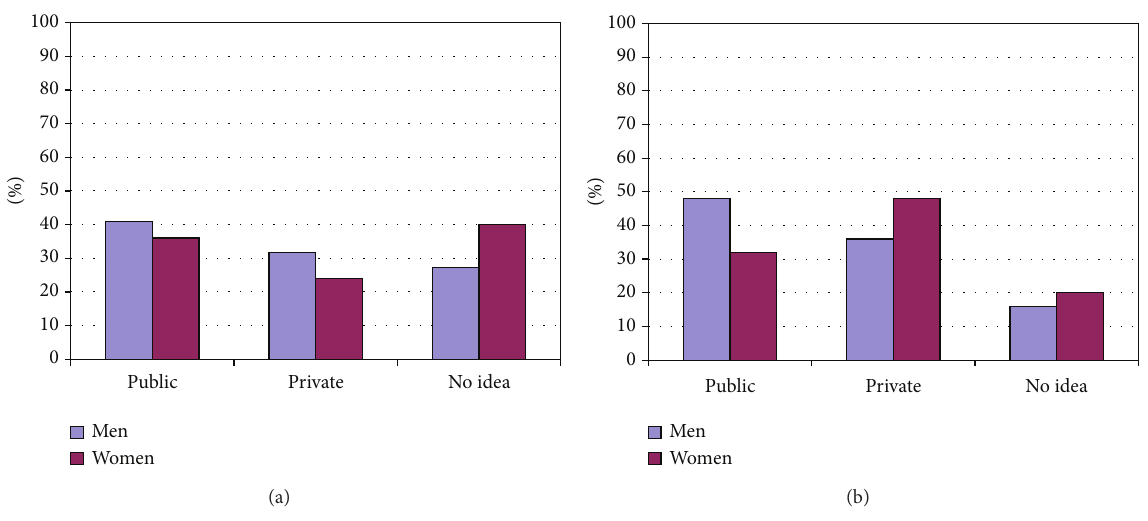
Figure 6: Type of personal profile over Twitter: DN (a) versus DI